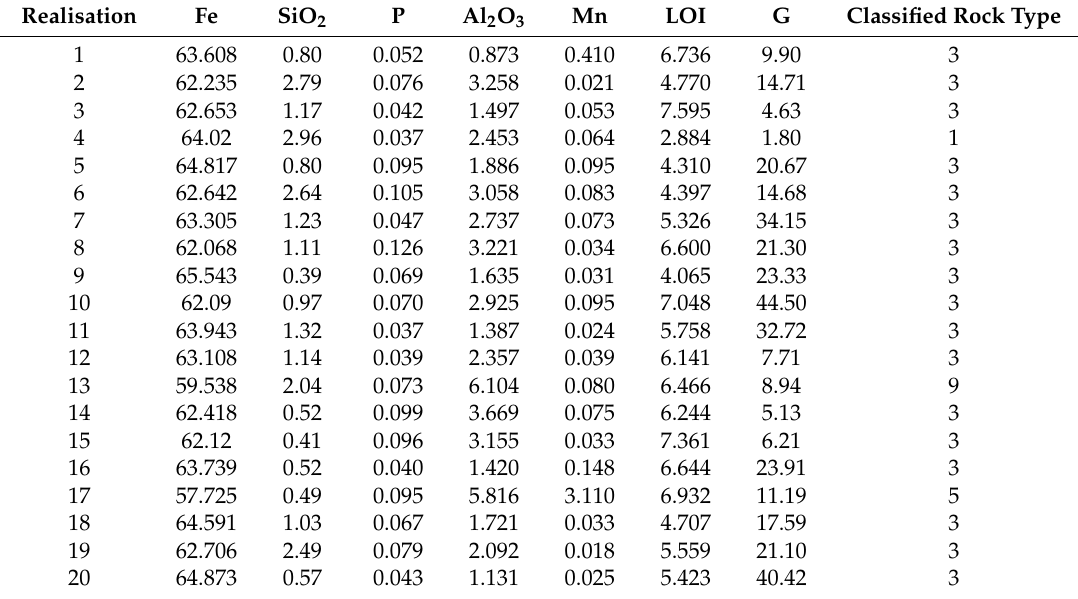
Table 9. Simulated grades and granulometry, and associated rock type, for 20 realisations of block n ◦ 3, interpreted as rock type 8 (friable iron-rich itabirite) by mining geologists.